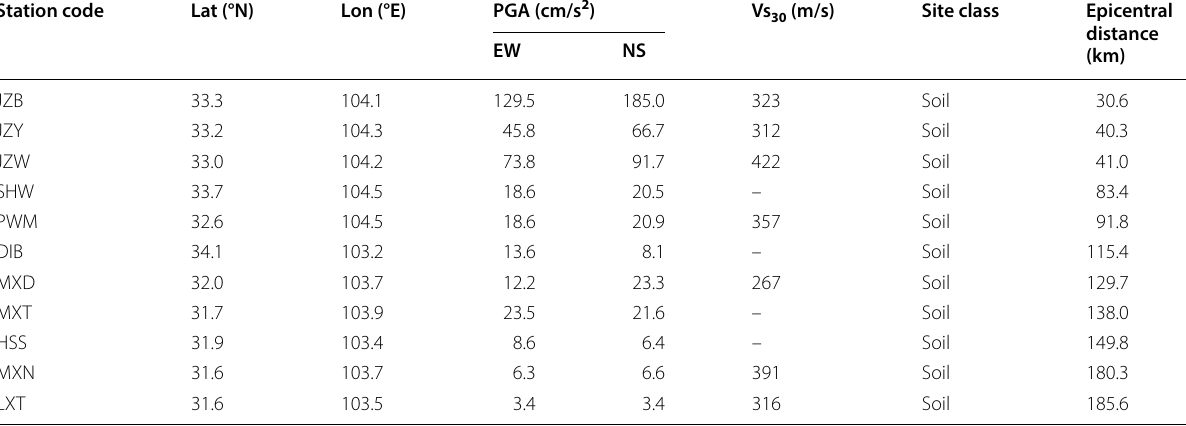
Table 1 Information on the strong‑motion stations used in this study Station